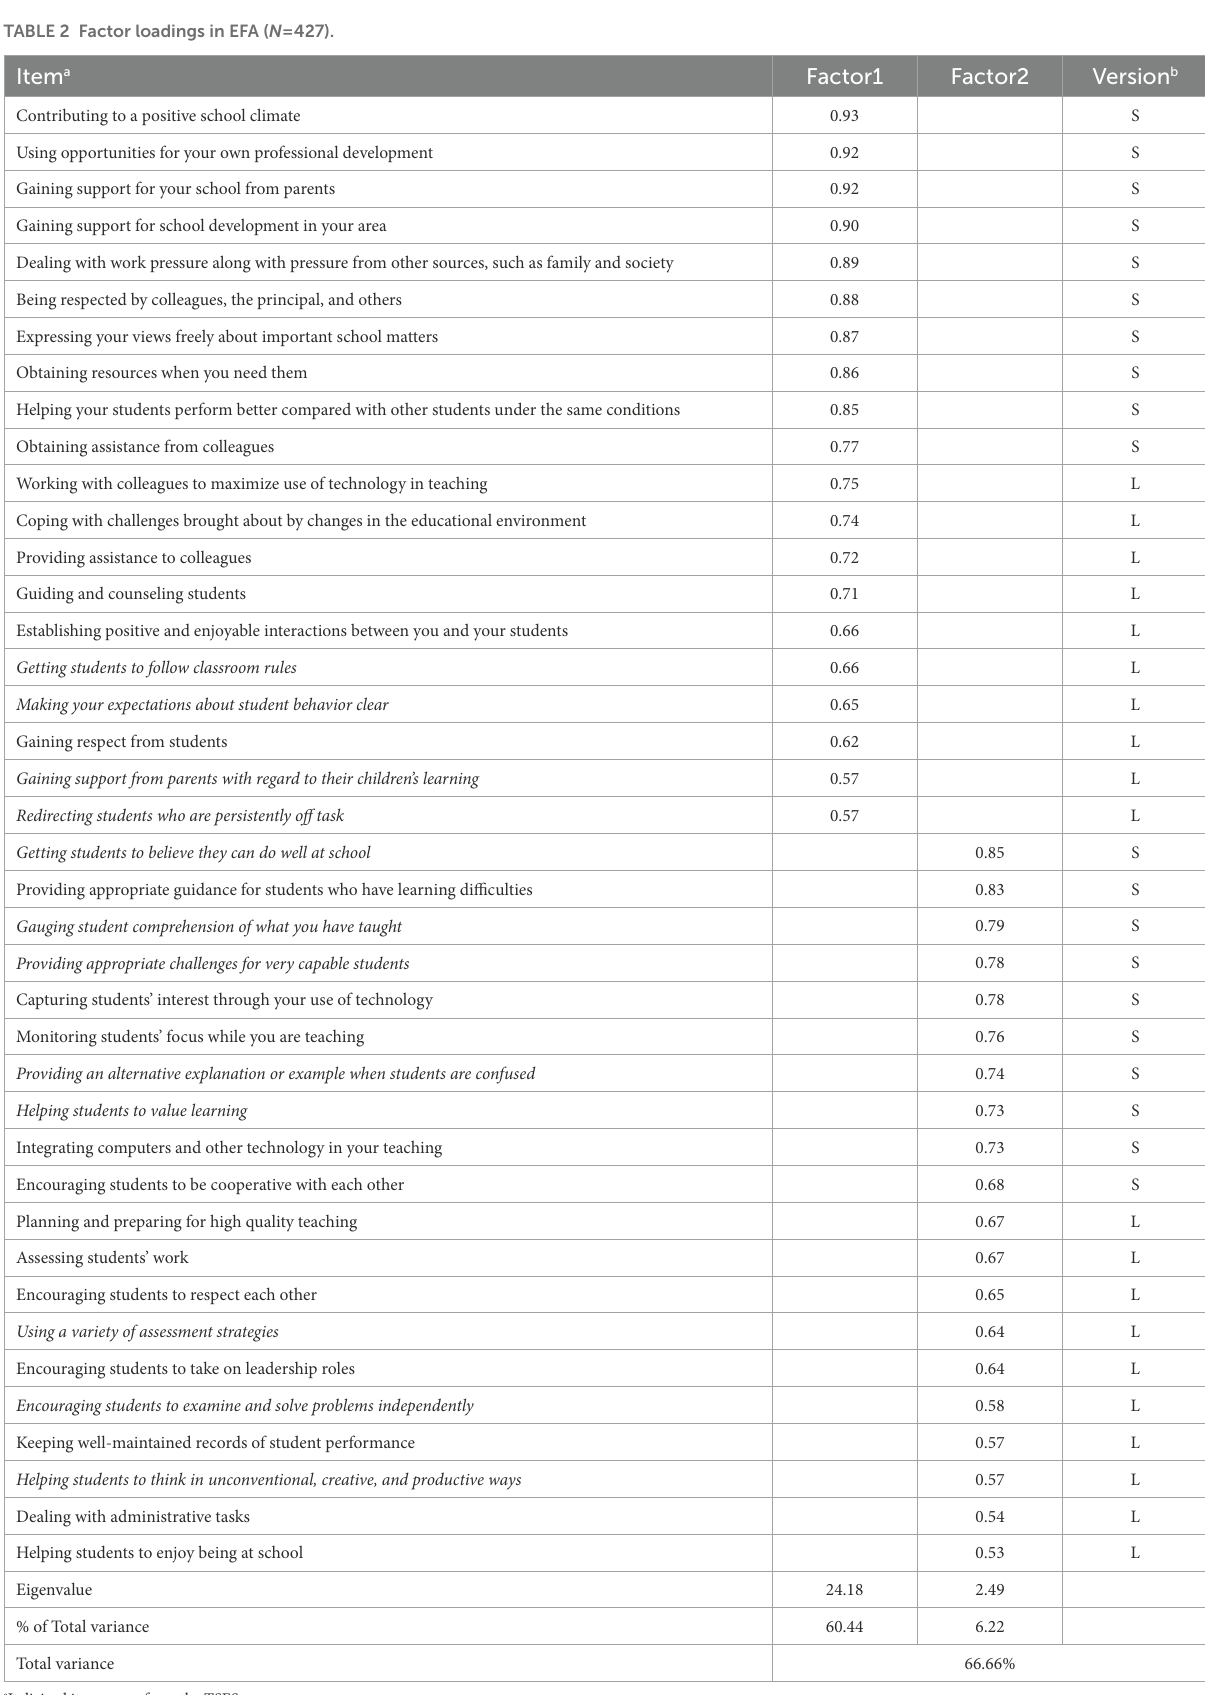
TABLE 2 Factor loadings in EFA ( N =